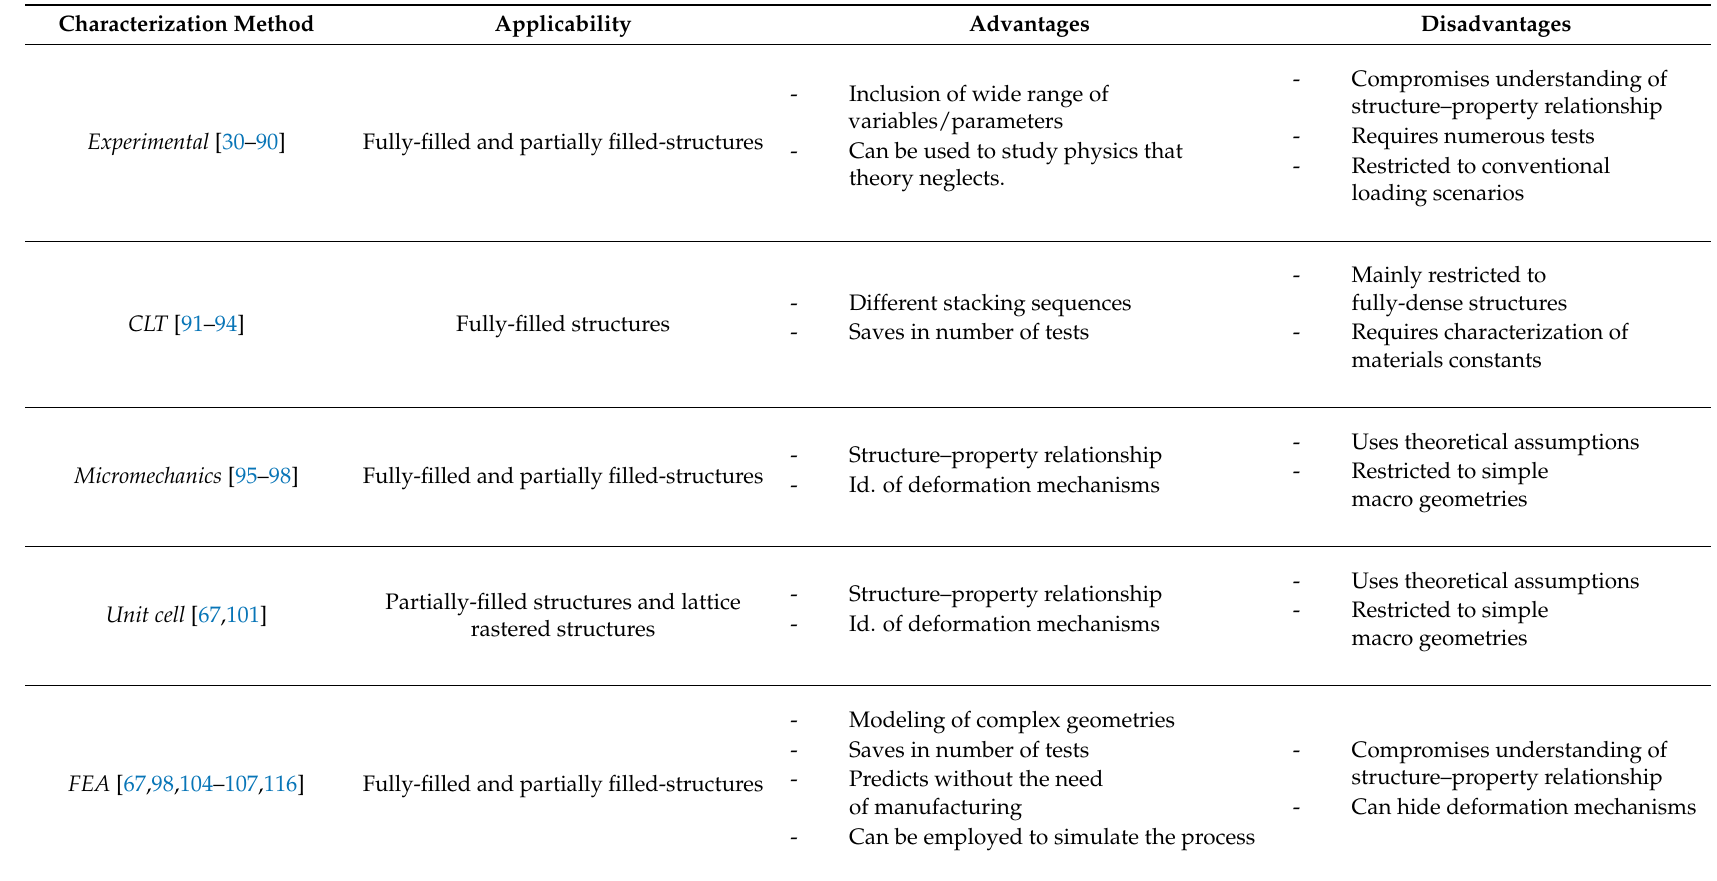
Table 2. Comparison of the different characterization